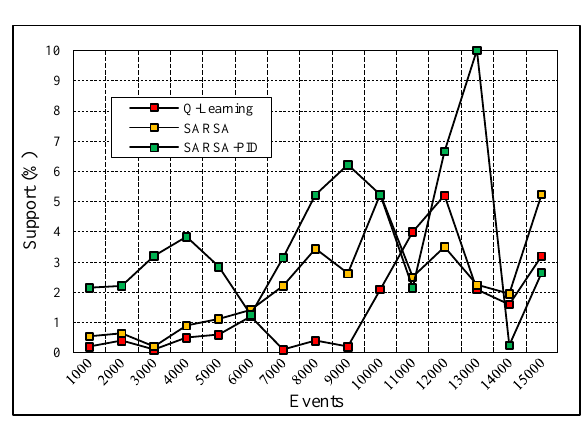
Figure. 4. The Support rate